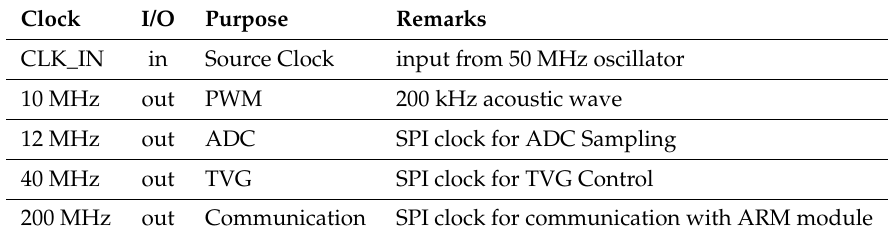
Table 3. Input/output clocks to/from FPGA.